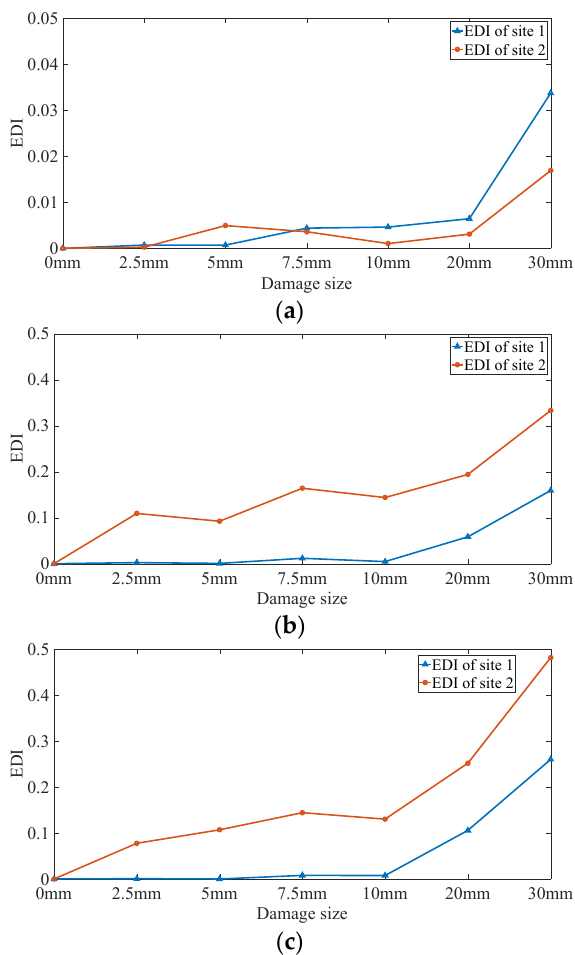
Figure 14. Energy-based damage index of DUW signals: ( a ) 1–10 ms, ( b ) 10–20 ms, and ( c ) 20–30 ms.